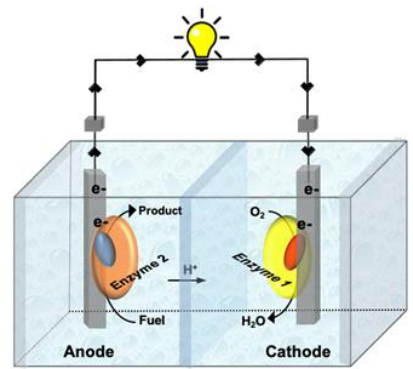
Figure 1. Schematics of an enzymatic fuel cell (EFC).